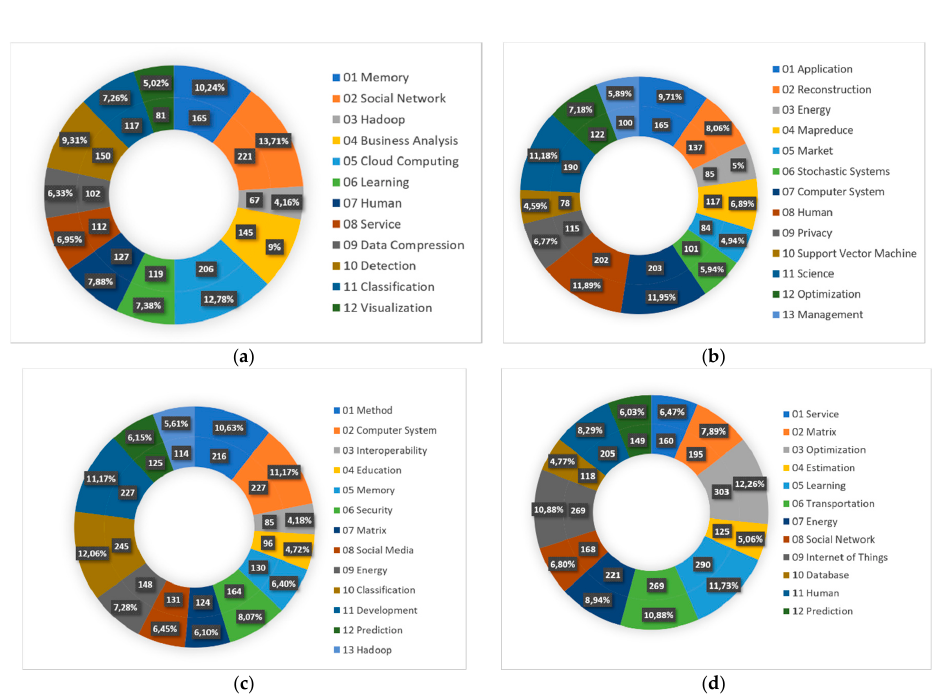
Figure B1. The number of keywords and their percentage, respectively, in each cluster. ( a ) 2009–2015; ( b ) 2016; ( c ) 2017; ( d ) 2018.